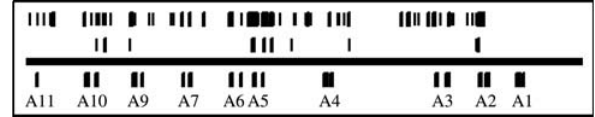
Figure 1 - Sequence conservation in HoxA cluster. Thick horizontal line indicates the range which has been analyzed, with position of HoxA genes indicated below it (all Hox genes have two exons). The bars right above the line indicate the positions of larger (50-400 bp) environments con- served at, or below, 0.1 average parsimony level, and the bars above them indicate the positions of shorter (25-100 bp) regions at the same level of conservation.